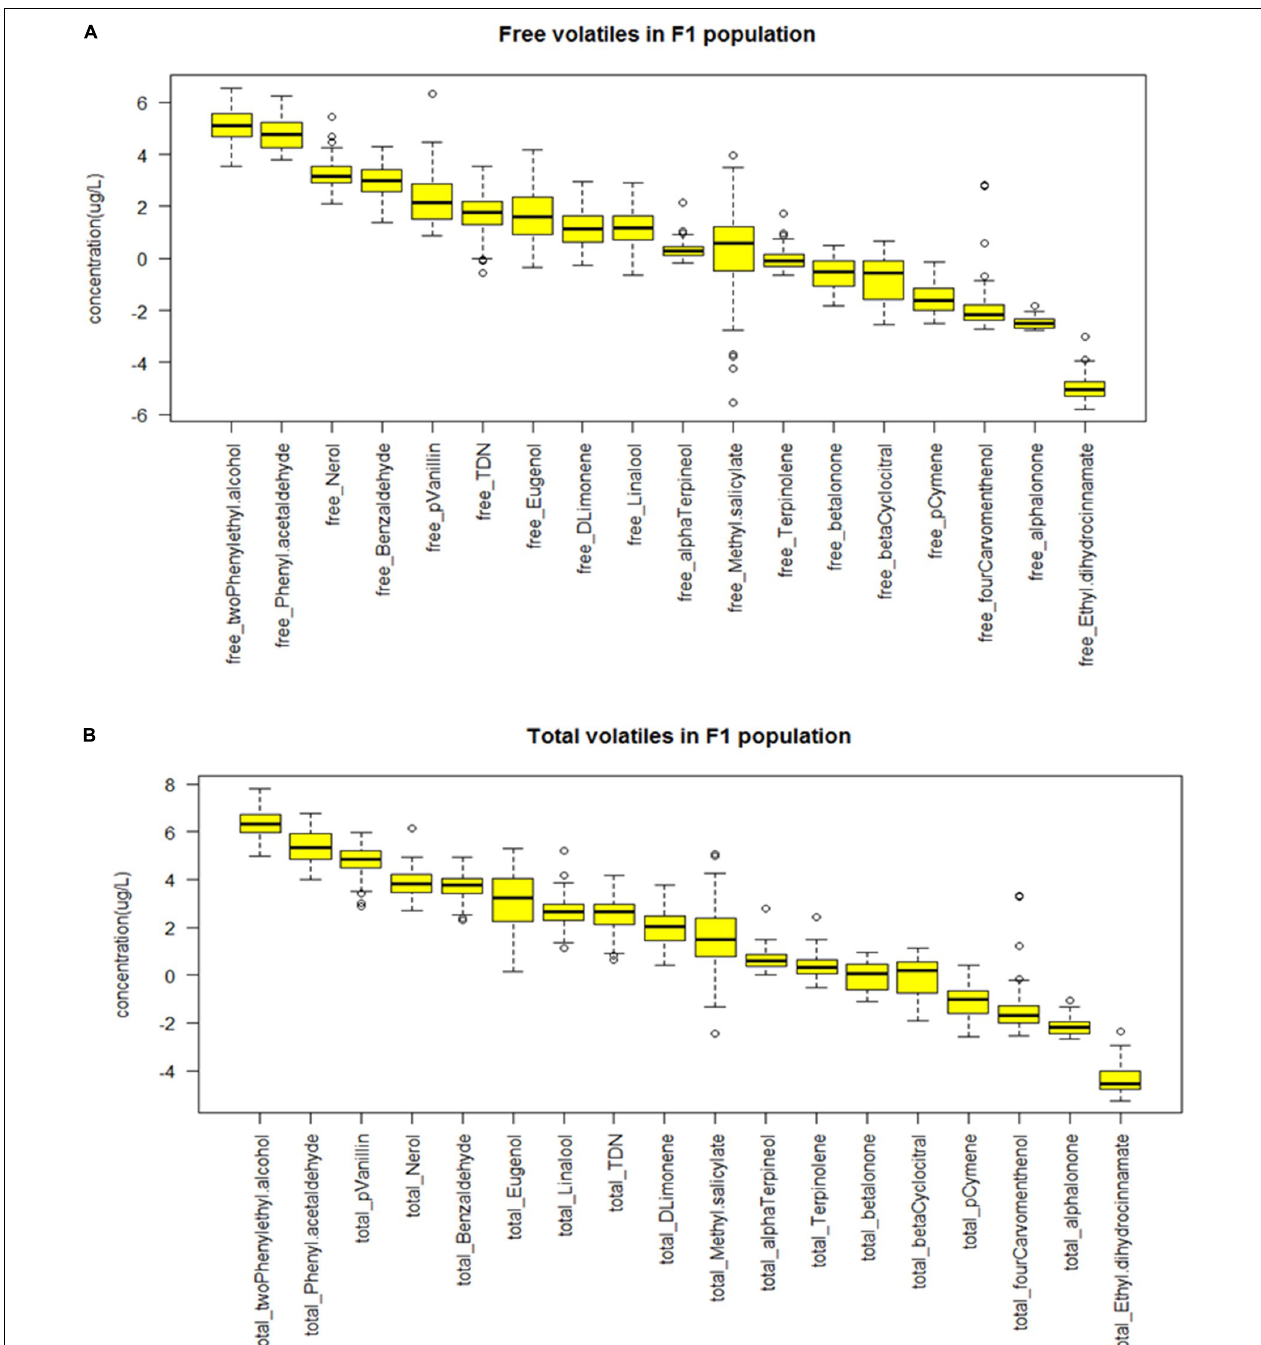
FIGURE 7 | Boxplots demonstrating the variability of the (A) free and (B) total volatiles in F1 population cross from Norton and Cabernet Sauvignon (Cab). The concentrations of the volatiles in µ g/L were